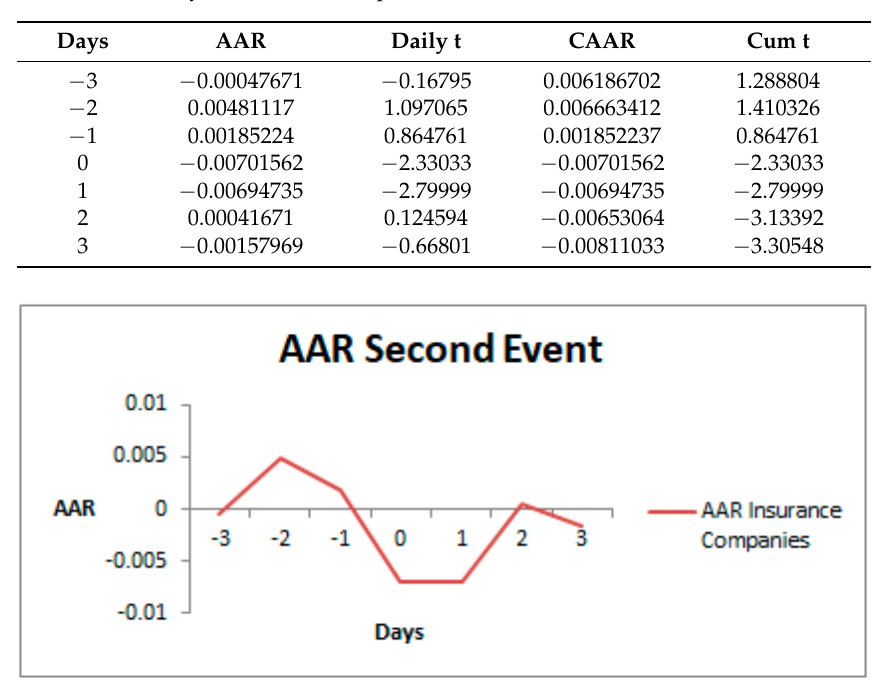
Figure 11. AAR for insurance companies. Source: Authors’ work.